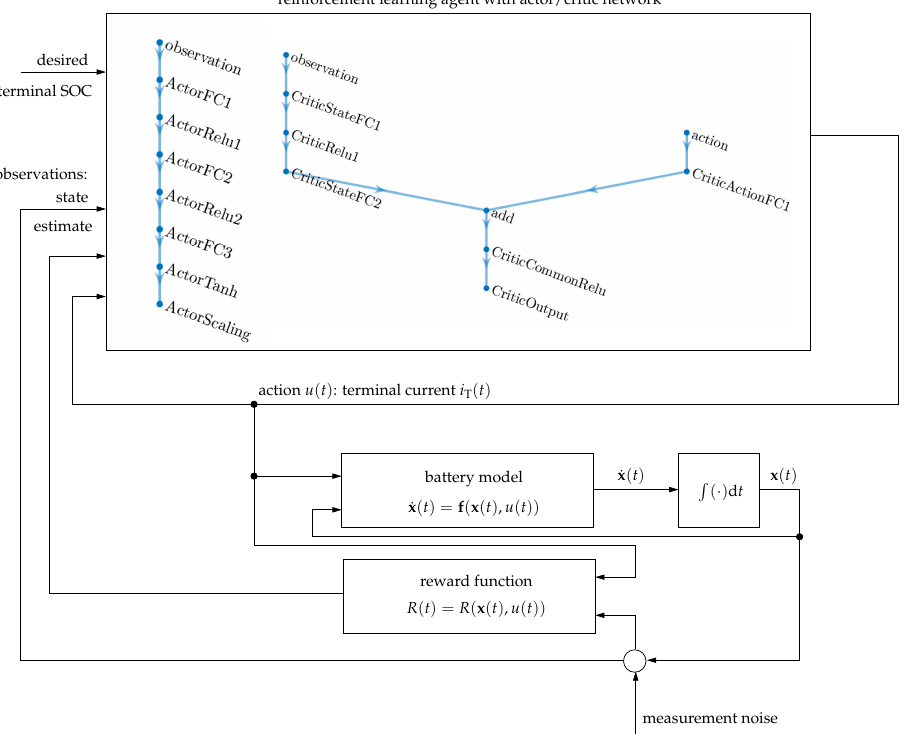
Figure 4. Structure of the reinforcement learning